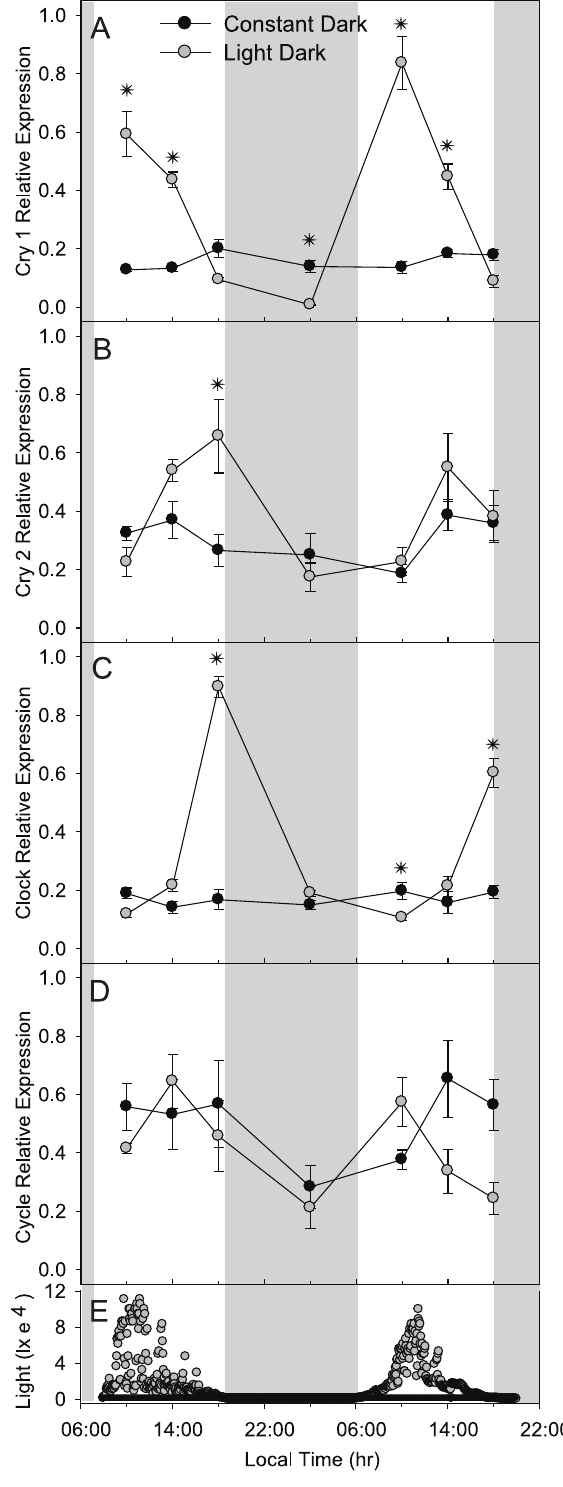
Figure 5. Relative expression of F. fragum clock genes in light:dark and constant Dark treatments. Relative expression of cry1 (A), cry2 (B), clock (C), and cycle (D) normalized to total RNA and ef1 a expression (as described in the Materials and Methods) are shown as the mean 6 s. e. m. (n=4) for light:dark (white circles) and constant dark (black circles) treatments. Light levels (lx) were measured every 5 min for light:dark (E, white circles) and constant dark treatments (E,